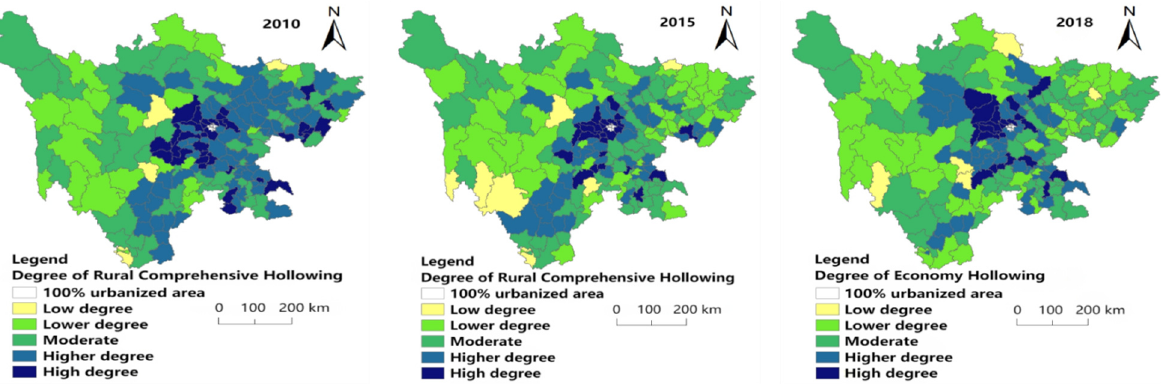
Figure 7. Spatial distribution of comprehensive hollowing degree in 2010, 2015 and 2018.